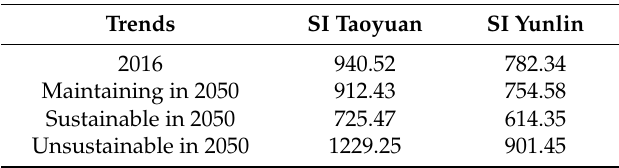
Table 5. Scenario simulation